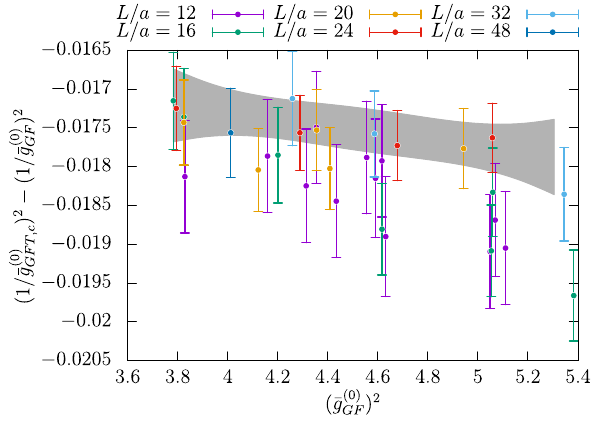
Fig. 6 Fit to match the schemes ¯ g ( 0 )